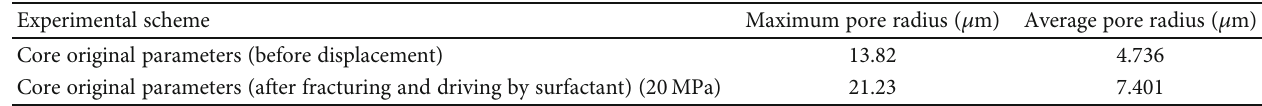
Table 3: The measurement results of core pore parameters under di ff erent displacement methods. Experimental